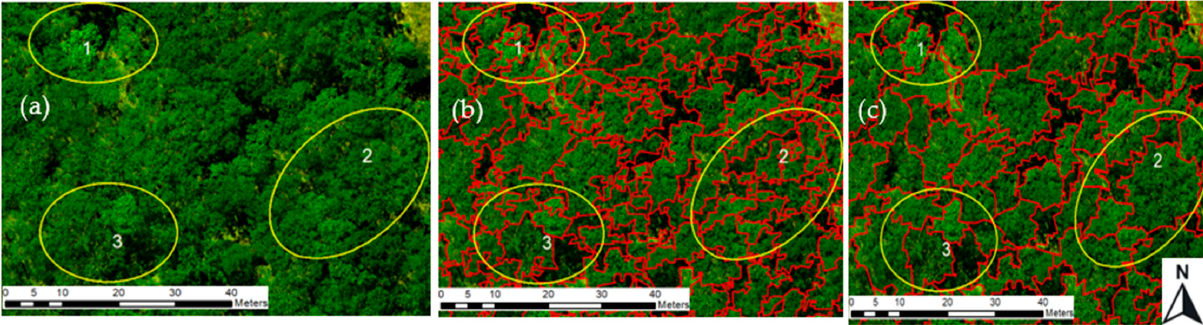
Figure 3. Visual comparison of segmentation using different scale parameter: ( a ) 50 (oversegmenta- tion); ( b ) 80 (correct segmentation); and ( c ) 150 (undersegmentation). Table 4. Segmentation accuracy of using UAS orthophoto and combination of UAS orthophoto and CHM.